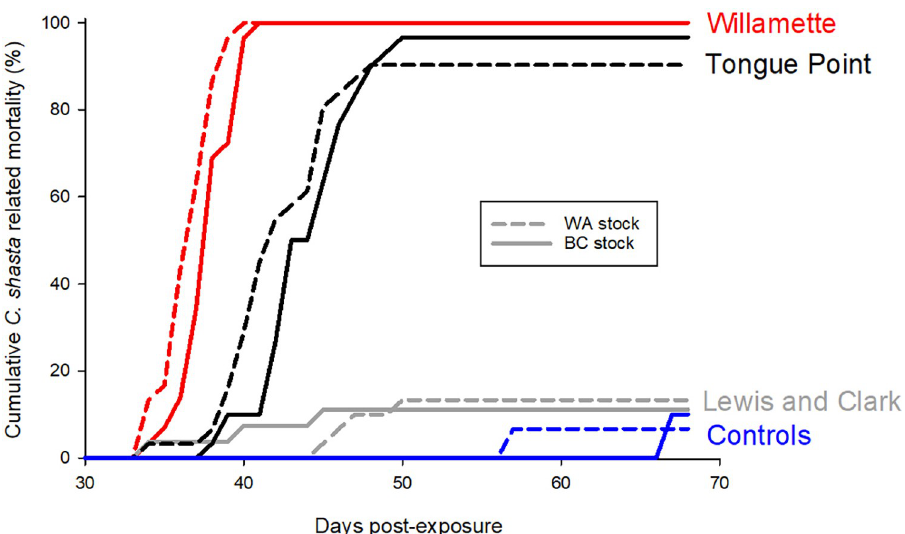
Fig 3. Cumulative percent mortality of chum salmon Oncorhynchus keta fry from Washougal Hatchery (WA stock) and Big Creek Hatchery (BC stock) exposed to Ceratonova shasta at sentinel sites on the Willamette River, Columbia River at Tongue Point, and Lewis and Clark River. Mortalities are only included if C . shasta myxospores were observed or if infection was confirmed through PCR. Mortality in hatchery control groups was from natural causes (n =